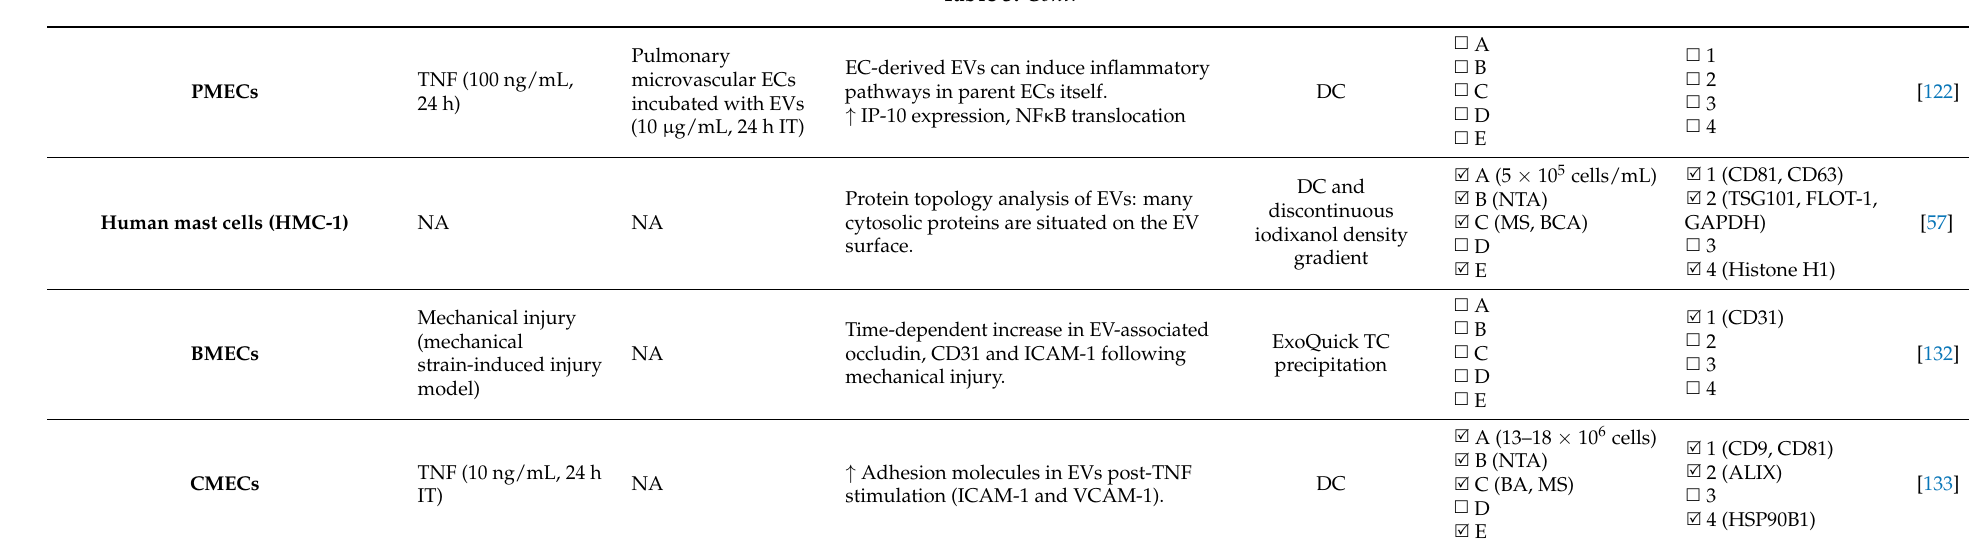
Total EV amount in same range for DIC and non-DIC patients. Specific EV source pattern in DIC patients. ↓ Platelet-derived EVs in DIC patients compared to non-DIC patients ↑ EC-EVs and leukocyte EVs in DIC (D1) No difference in EV levels between sepsis/septic shock patients and healthy